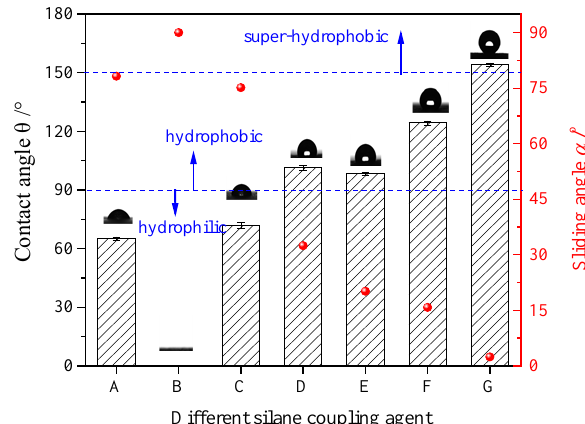
Figure 5. Influence of UFAs modified using different silane coupling reagents on the coating hydrophobicity. (Bar: contact angle, red dot: sliding angle; A-blank slide, B-UFA, C-PTES+UFA, D-KH550+UFA, E-KH570+UFA, F-TMCS+UFA, and G-HFDS+UFA; Preparation conditions: 1 mL silane coupling reagents, 5 g UFA, and 50 mL ethanol).